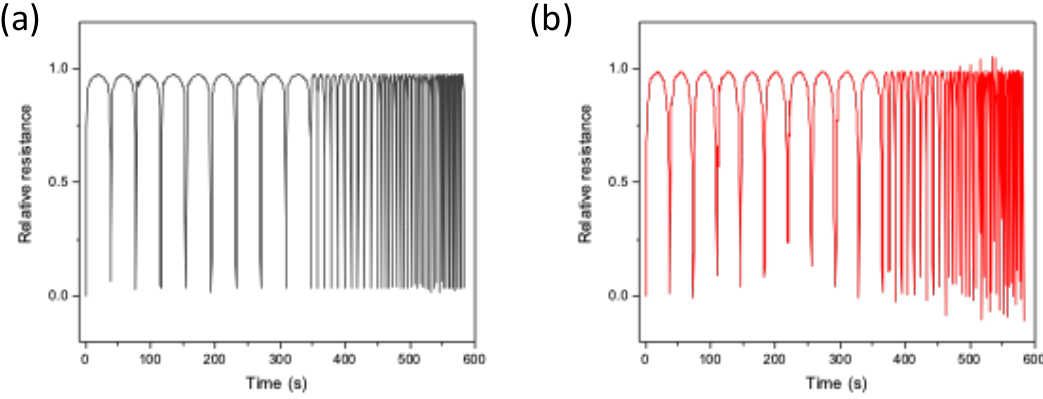
Figure 8. Dynamic piezoresistive properties of PDMS/CNTs long ( a ) and PDMS/CNTs short ( b ) sponges at strain rates of 5, 20, 35, 45 and 60 mm/min (10 cycles for each step) in the range 0 – 20%.